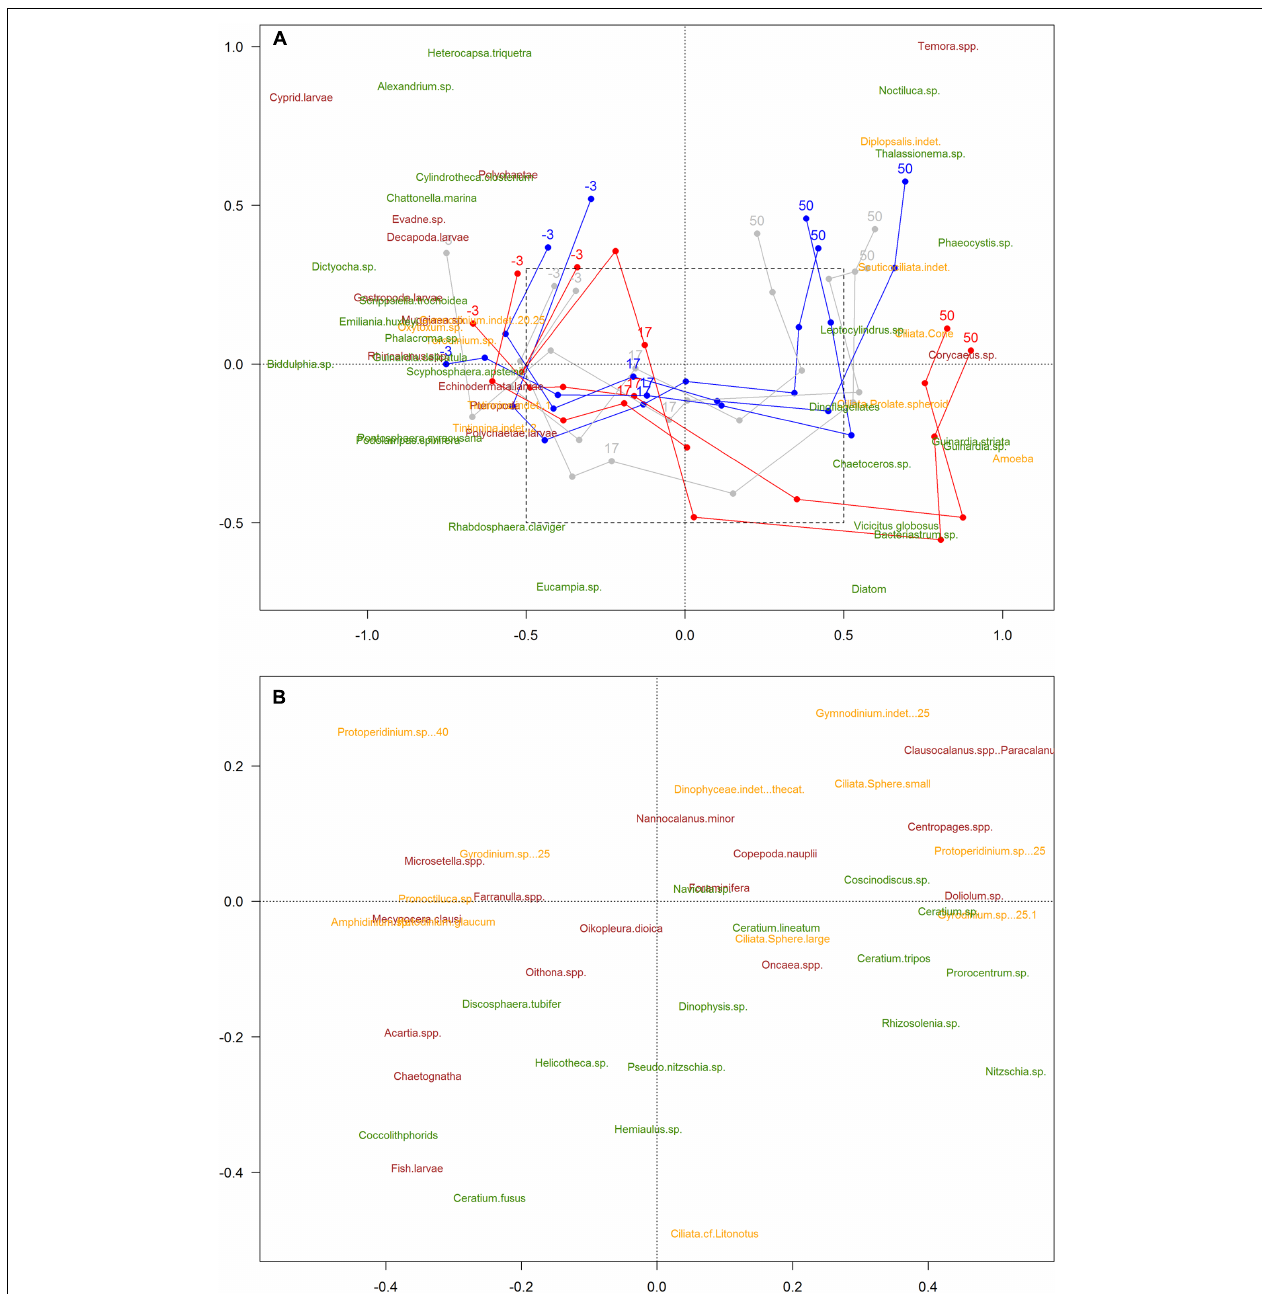
FIGURE 2 | Non-metric Multidimensional Scaling analysis (NMDS) of the plankton community (stress value = 0.18). Color code: blue = low- p CO 2 (M1, M5, and M9), gray = medium- p CO 2 (M3, M4, and M7), red = high- p CO 2 [M2, M6 (until t27), M8]. Only common species ( > 0.5% total abundances) represented. Taxa names: phytoplankton (green), microzooplankton (yellow), mesozooplankton (burgundy). The numbers -3, 17, and 51 indicate sampling days; lines represent patterns. Species are positioned in the graph according to their relative abundance during the experiment. Days of experiment included in the NMDS analysis were limited to t50, due to the absence of microZP samples for t56. Amplified area (B) is a zoom-in for a clearer view of the species that overlapped in the middle of the first graph [not shown in (A) for the sake of clarity].